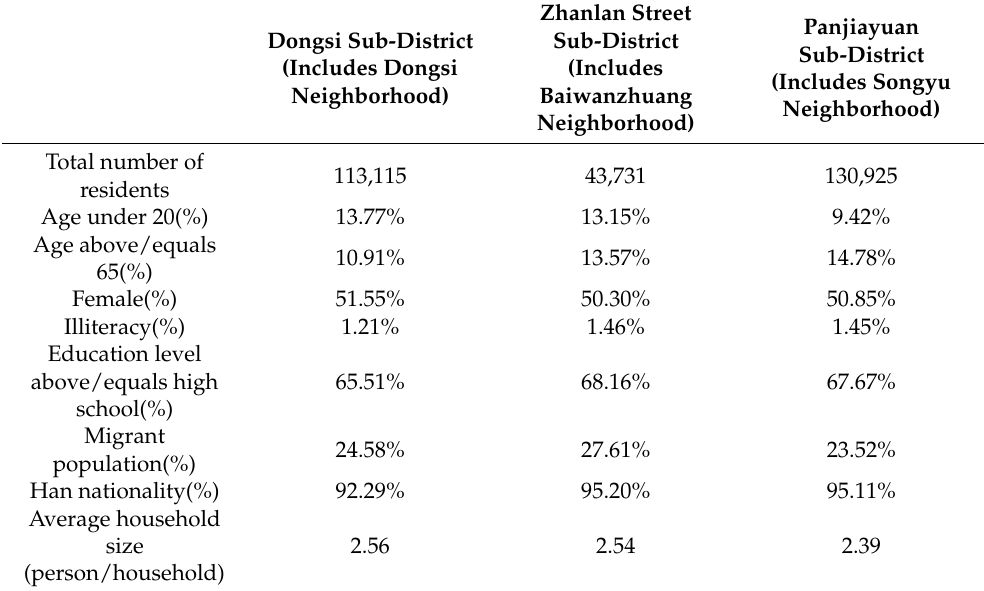
Table 3. The socio-demographic data of the three